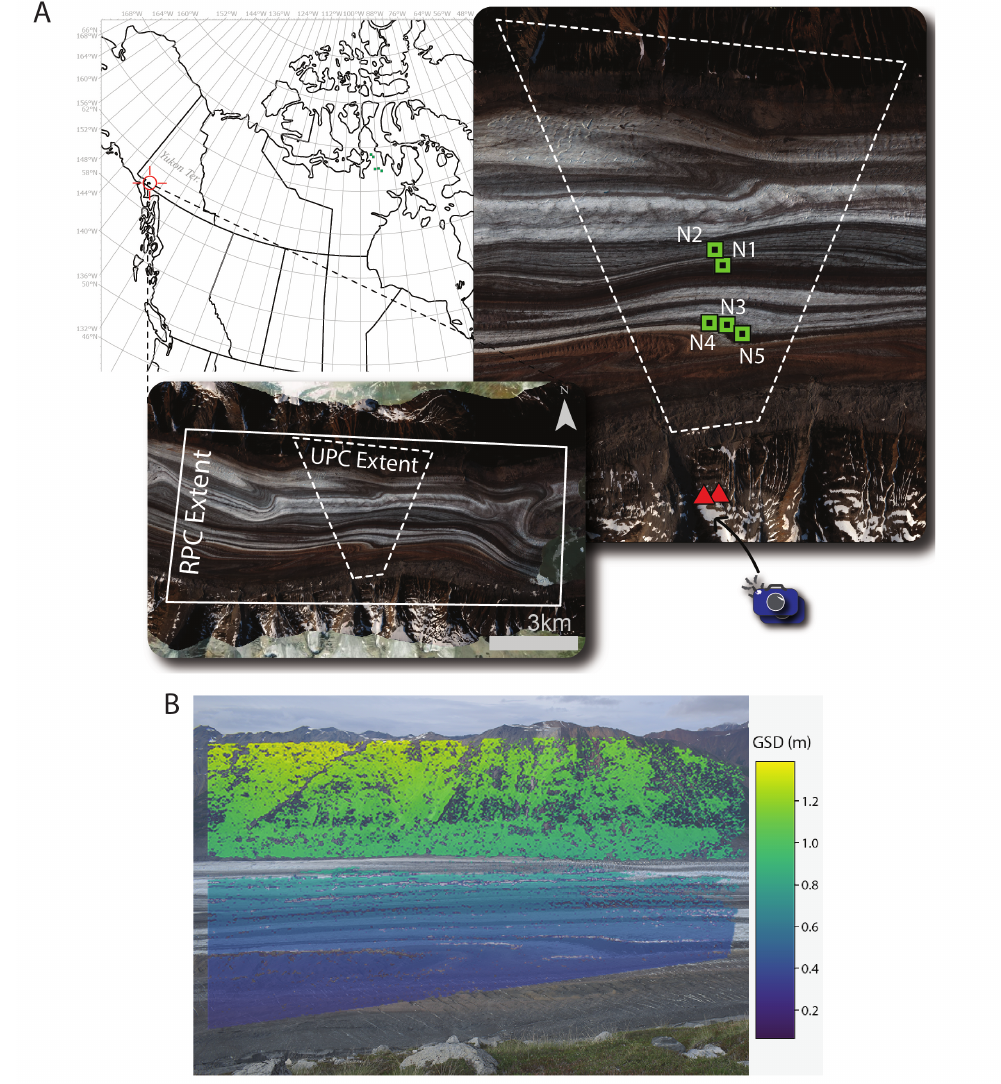
Figure 7. ( A ) Nàłùdäy, Yukon, Canada, was surveyed in July 2021. Two cameras were left in place collecting daily stereo image pairs (red triangles). The extent of the reference point cloud (RPC; solid outline) is shown in relation to the unreferenced point cloud (UPC; dashed outline). Surveyed control points are shown in green. ( B ) Example image from one of the cameras showing the view of the camera with the ground sampling distance